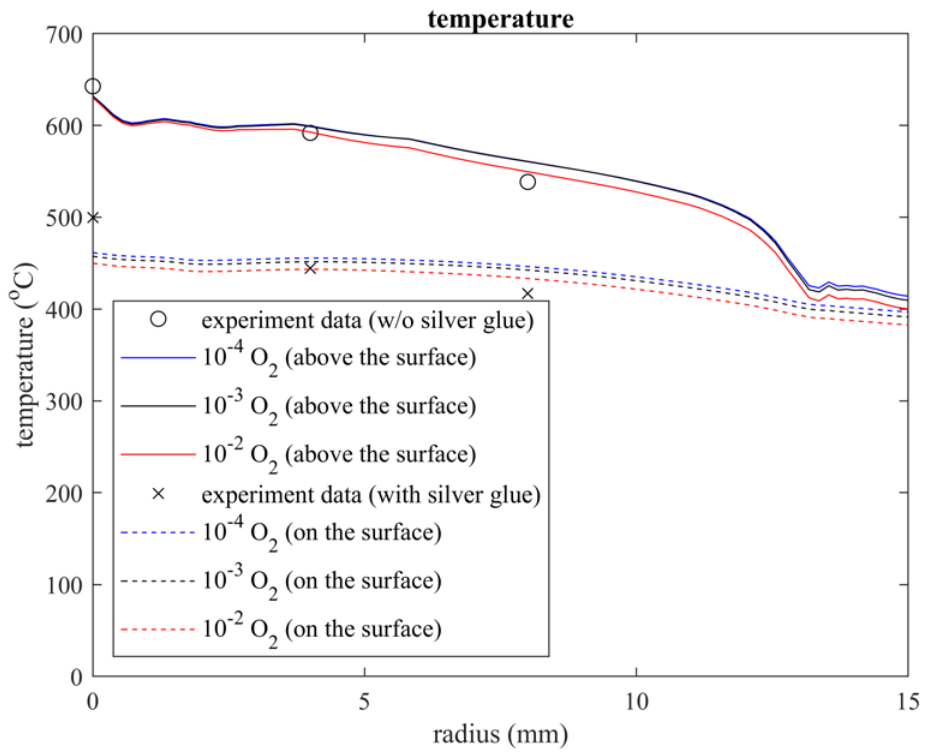
Figure 5. Temperature profile above and on the surface under the quartz tube region, in which the substrate is treated by the plasma.